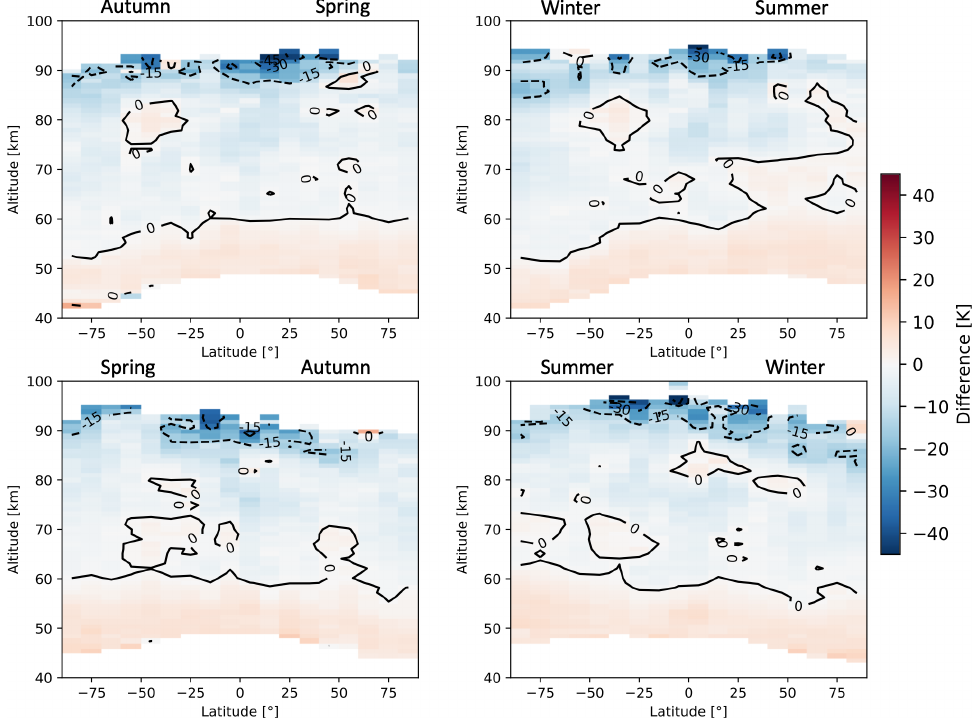
Figure A25. Seasonal zonal means of temperature FM19 SMR–MIPAS upper atmosphere absolute differences averaged over the time period indicated in Table 2. The seasons are intended as astronomical seasons, i.e. each starting at the respective solstice or equinox.